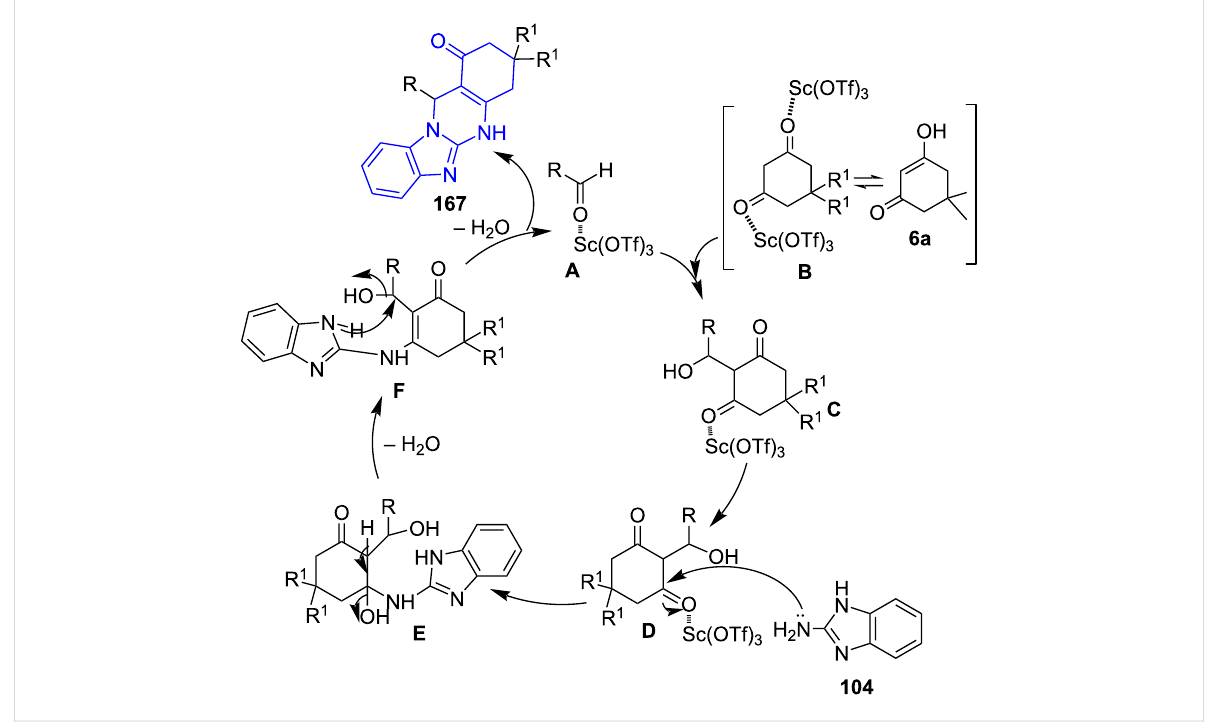
Scheme 68: Proposed mechanism for fused benzothiazolo/benzoimidazoloquinazolinones.